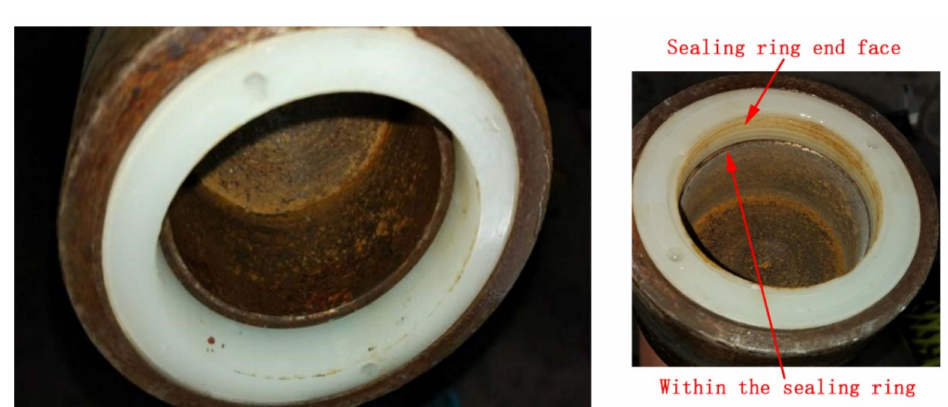
Figure 12. Bearing before the test.